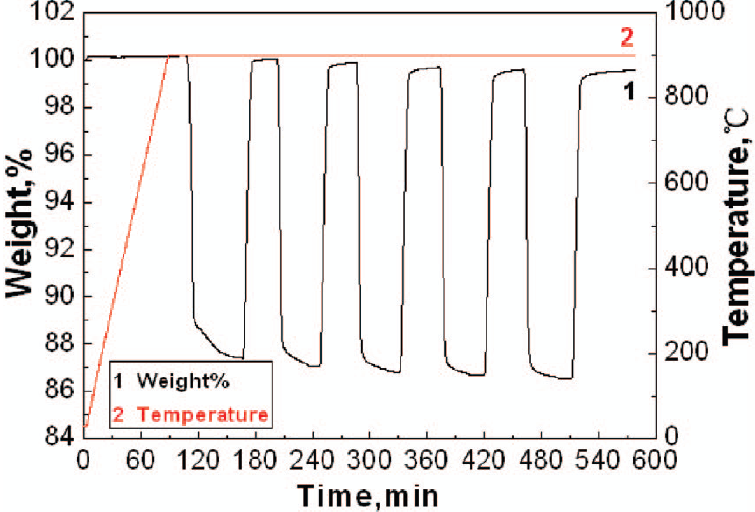
Figure 5. Weight change (TG) of multiple cycle reduction-oxidation reactions of NiO/NiAl 2 O 4 oxygen carriers and hydrogen/air